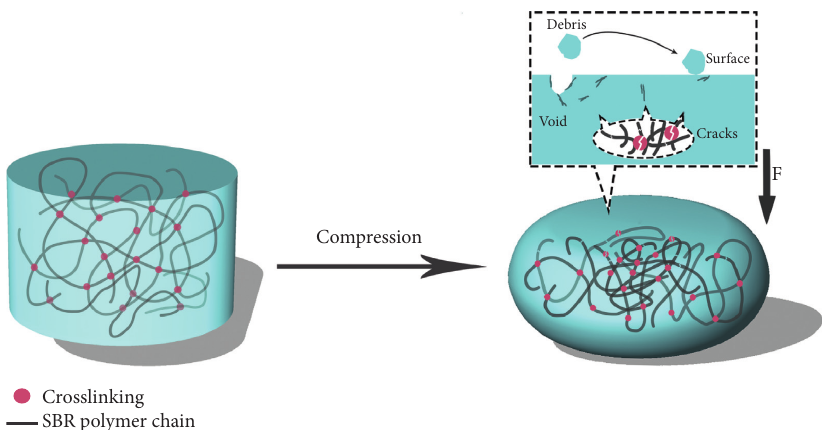
Figure 5: Characteristics of fatigue wear in rubber caused by repeated compressive stress cycles